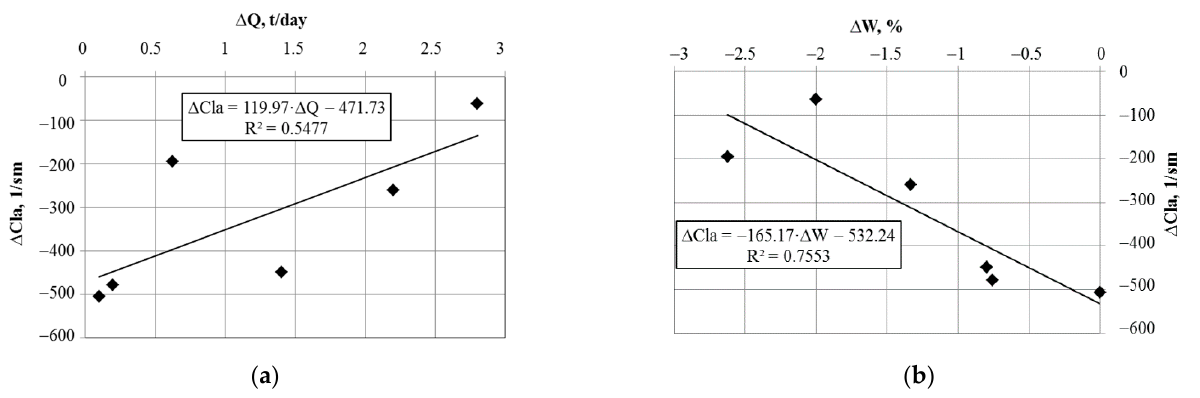
Figure 3. Change of water cut vs coefficient of light absorbance variation [100].